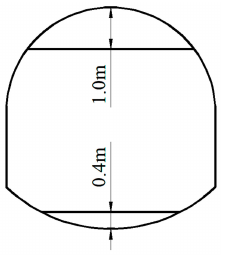
Figure 24. The parameters of the RFB